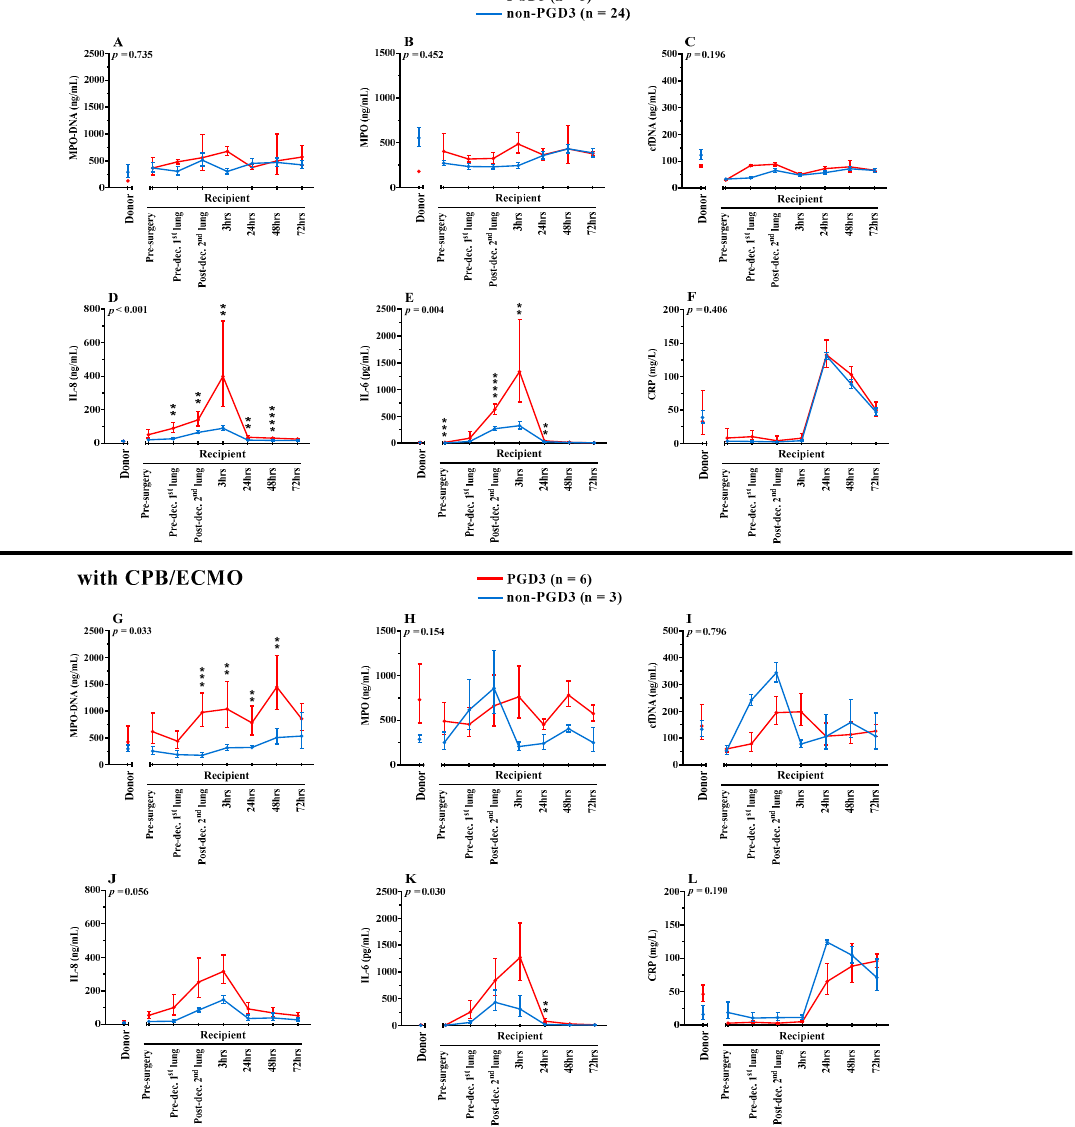
Figure 4. Serum levels of NETosis and inflammatory biomarkers in recipients without CPB/ECMO ( A – F ) (n = 27) or with CPB/ECMO ( G – L ) (n = 9). Donors (n = 25) and recipients’ (n = 36) pre-, intra- and postoperative serum levels of NETosis ( A – C , G – I ) and inflammatory ( D – F , J – L ) biomarkers are displayed. Blue lines show biomarkers in non-PGD3 recipients and red lines in PGD3 recipients (Mixed-method analyses). The 95% confidence intervals are represented with bars. p values represent the global inter-group comparisons over time. Significant time-point differences are illustrated with asterisks (*). ** p < 0.01, *** p < 0.001, **** p < 0.0001.